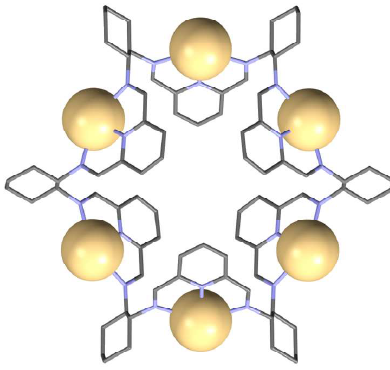
Figure 30. Macrocycle expansion reaction triggered by cadmium(II) template.